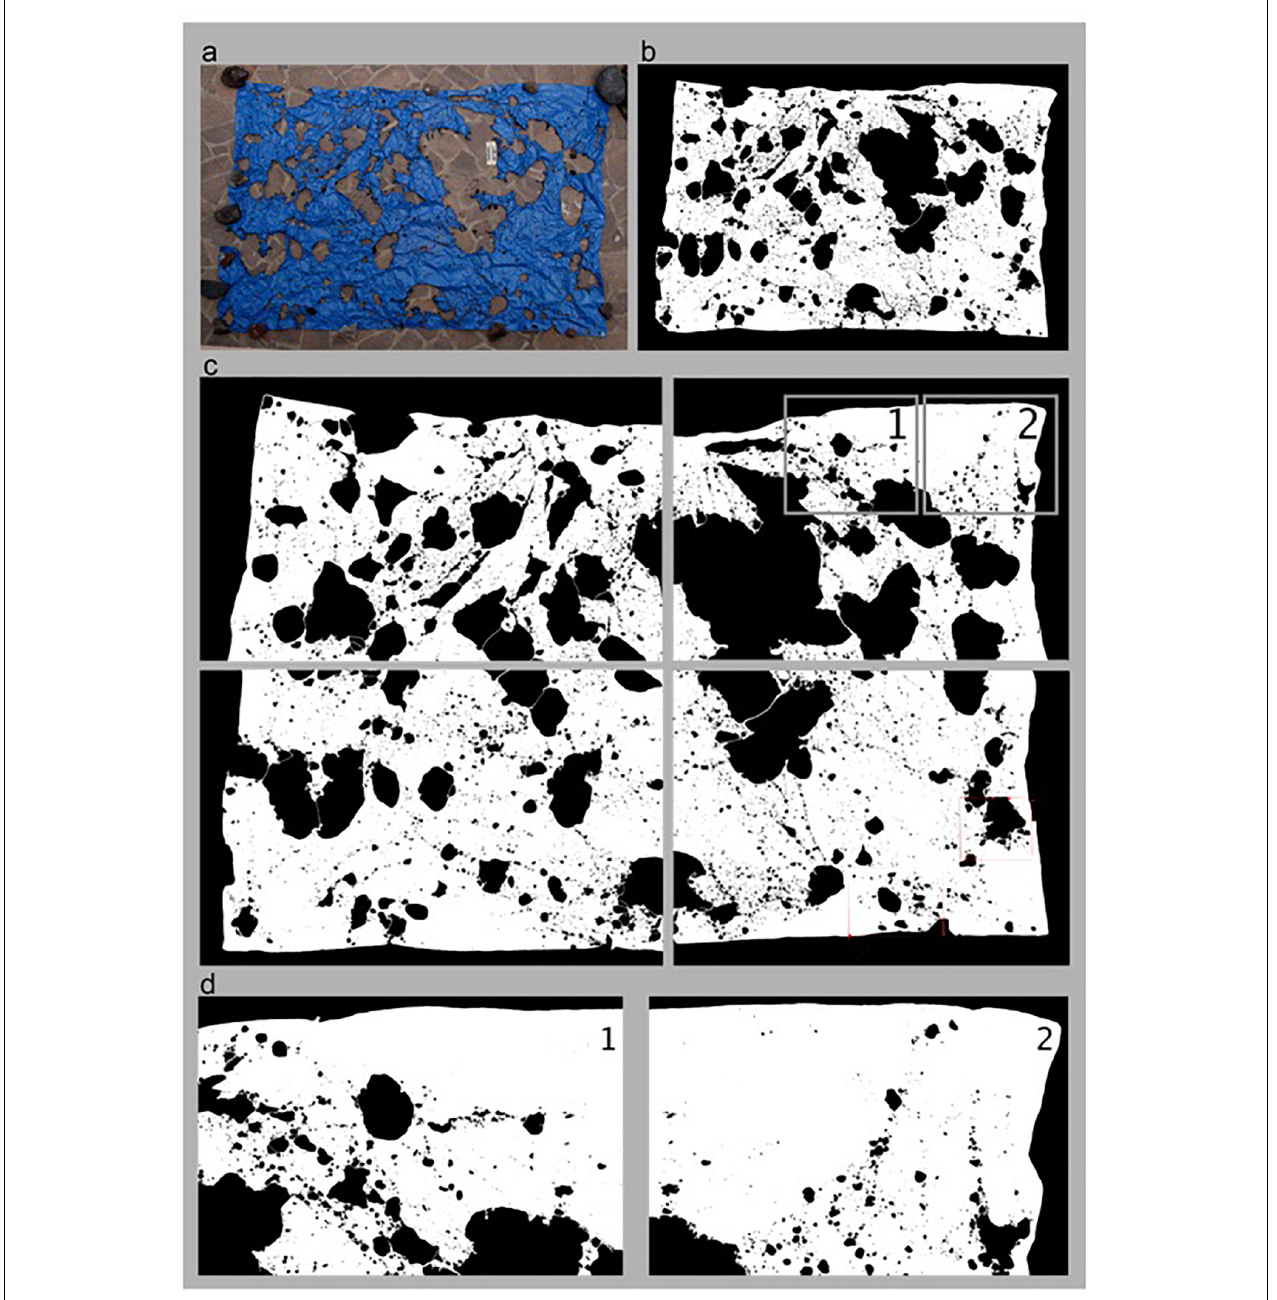
FIGURE 2 | (a) Photo of tarp 1. For scale 10 cm GSA scale bar is included and tarp is 3 × 2 m. Dimensions are the same for all the figures. (b) Image of tarp 1 after image processing (holes = black, plastic = white). (c) Processing of images with increasing magnification, where areas marked by gray boxes marked “1” and “2” are magnified in (d)